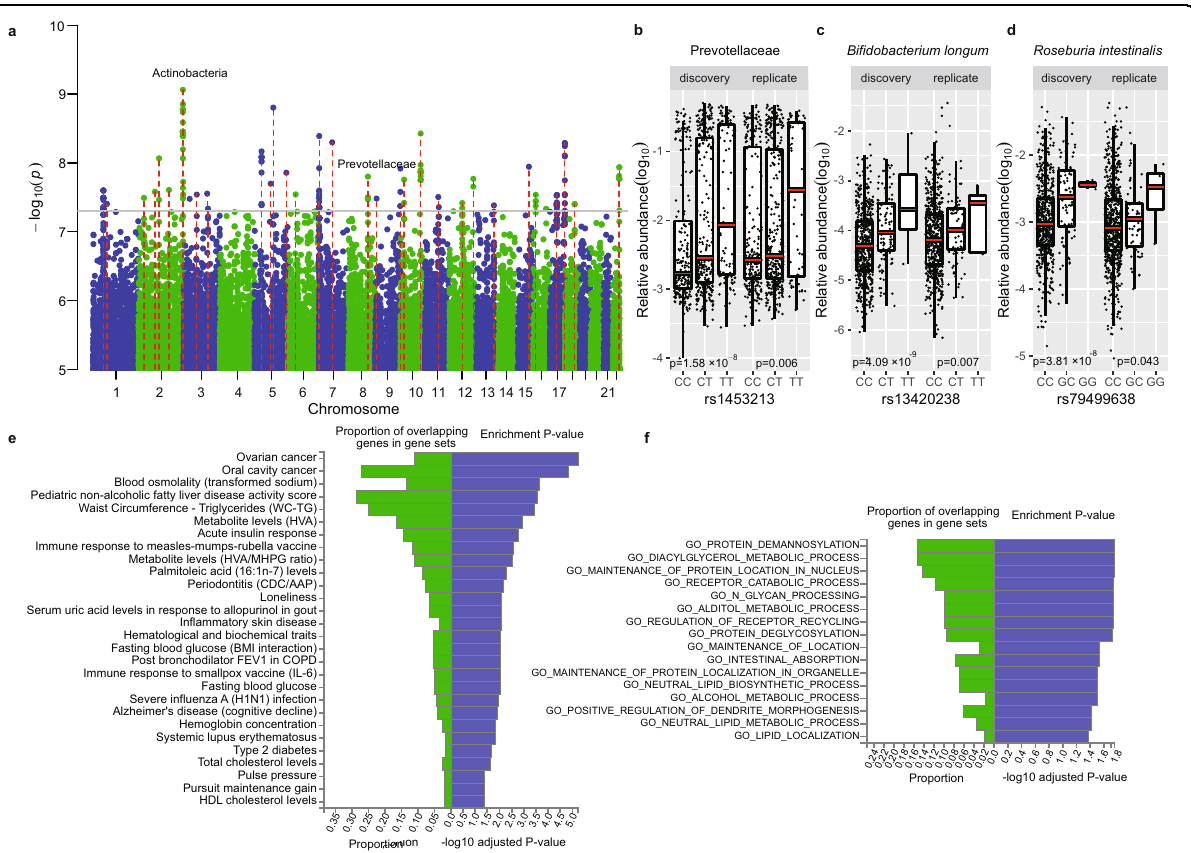
Fig. 2 M-GWAS results for the gut microbiome and functional analysis. a Manhattan plot showing the associations between common variants and taxa, only suggestive associations with P < 10 − 5 were showed. The gray line represents a genome-wide signi fi cant P value (5 × 10 − 8 ). The red lines showed the 37 loci reaching the genome-wide signi fi cance. Two high heritable taxa, Actinobacteria linked to rs13420238 at LOC150935 and Prevotellaceae linked to rs1453123 at OXR1 , were marked. b rs1453123 at OXR1 associated with Prevotellaceae both in discovery ( P = 1.58 × 10 − 8 ) and replication ( P = 0.006) cohort. c rs13420238 at LOC150935 associated with Bi fi dobacterium longum (Actinobacteria) both in discovery ( P = 4.09 × 10 − 9 ) and replication ( P = 0.007) cohort. d rs79499638 near PLXDC2 associated with Roseburia intestinalis both in discovery ( P = 3.81 × 10 − 8 ) and replication ( P = 0.043) cohort. e Enriched traits or diseases identi fi ed in GWAS catalog using 109 mapped genes from 37 signi fi cant loci. f Enriched KEGG or GO pathways identi fi ed for 109 mapped genes from 37 signi fi cant